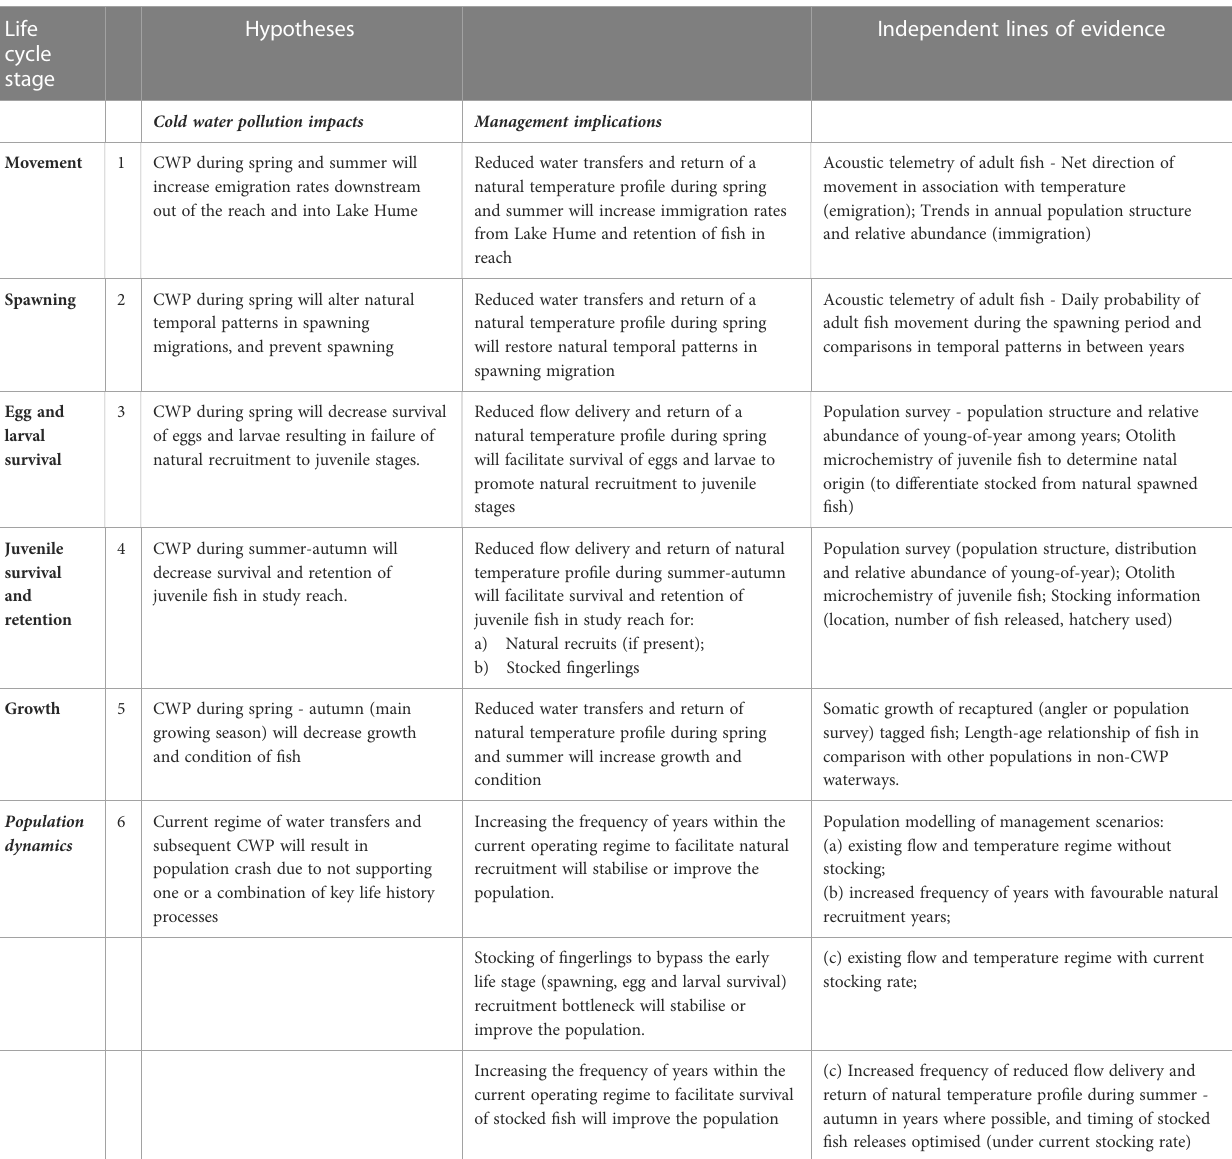
TABLE 1 Hypotheses for the effects of cold water pollution (CWP) on key life cycle stages and population dynamics of Murray cod; management implications or opportunities for each; and the lines of evidence used in this study to test these